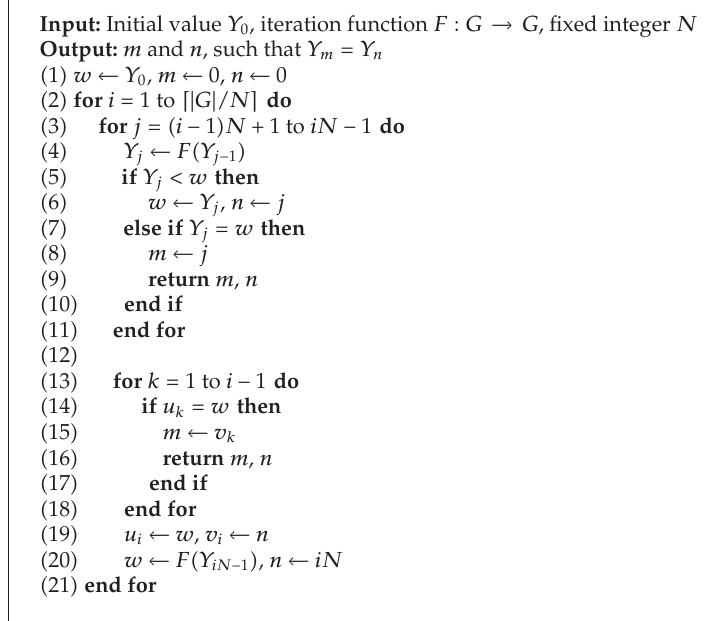
Algorithm 1: The new algorithm for collision